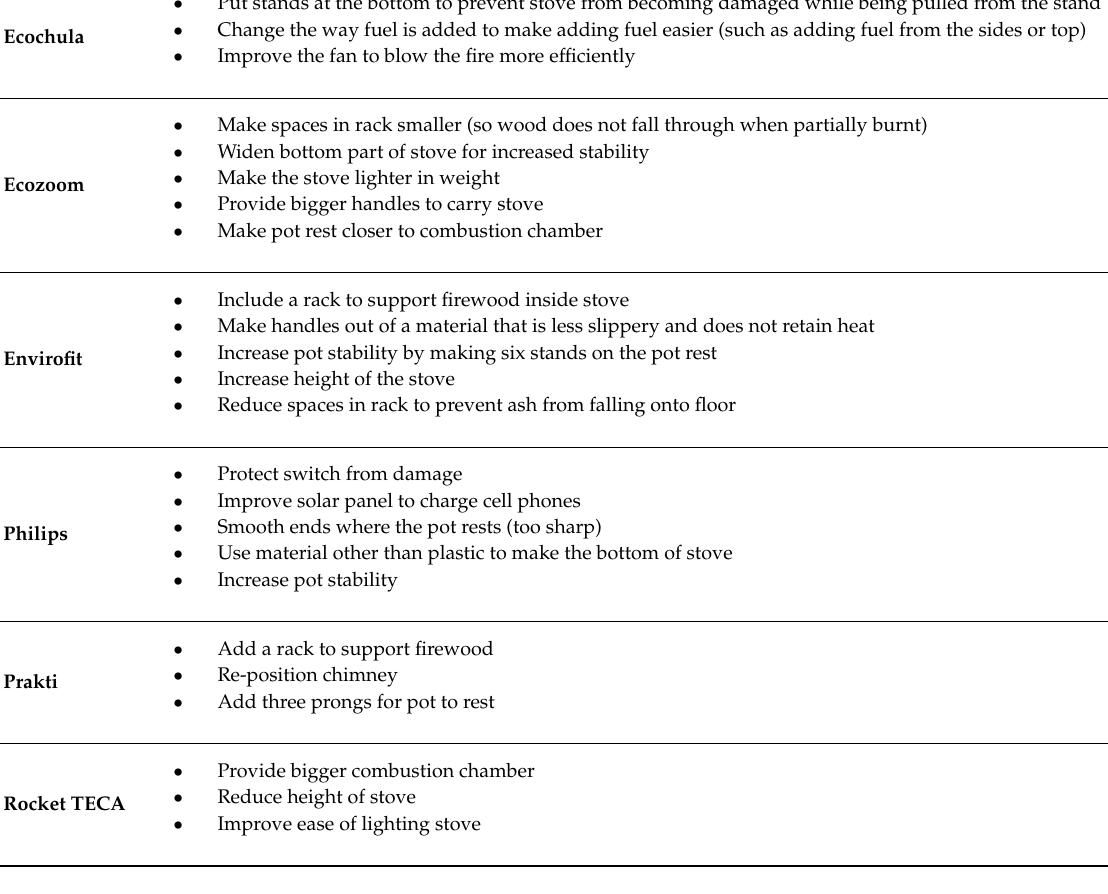
Table 1. Suggested improvements of improved